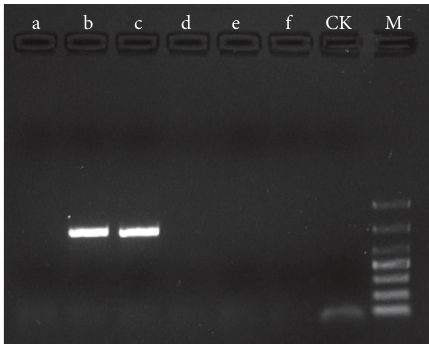
Figure 1: Reverse transcriptase PCR amplification of the partial hsp gene. Lane a: the noninoculated reactor on the 20th day; Lane b–f: inoculated reactors with 0.55 ± 0.01 , 1.10 ± 0.03 , 1.66 ± 0.04 , 2.21 ± 0.05 , and 2.76 ± 0.07 mg/g (dry weight of strain HF-1/dry weight of activated sludge) inoculum amount on 20th day, respectively; Lane CK: original activated sludge at 0 day; Lane M: DL 1000